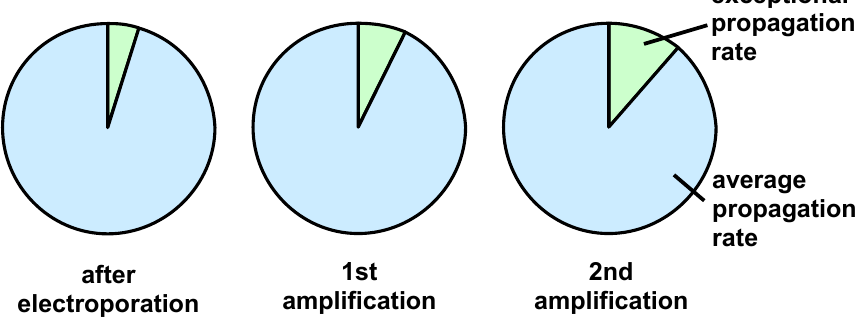
Figure 3. Schematic illustration of the results obtained with clones possessing different propagation